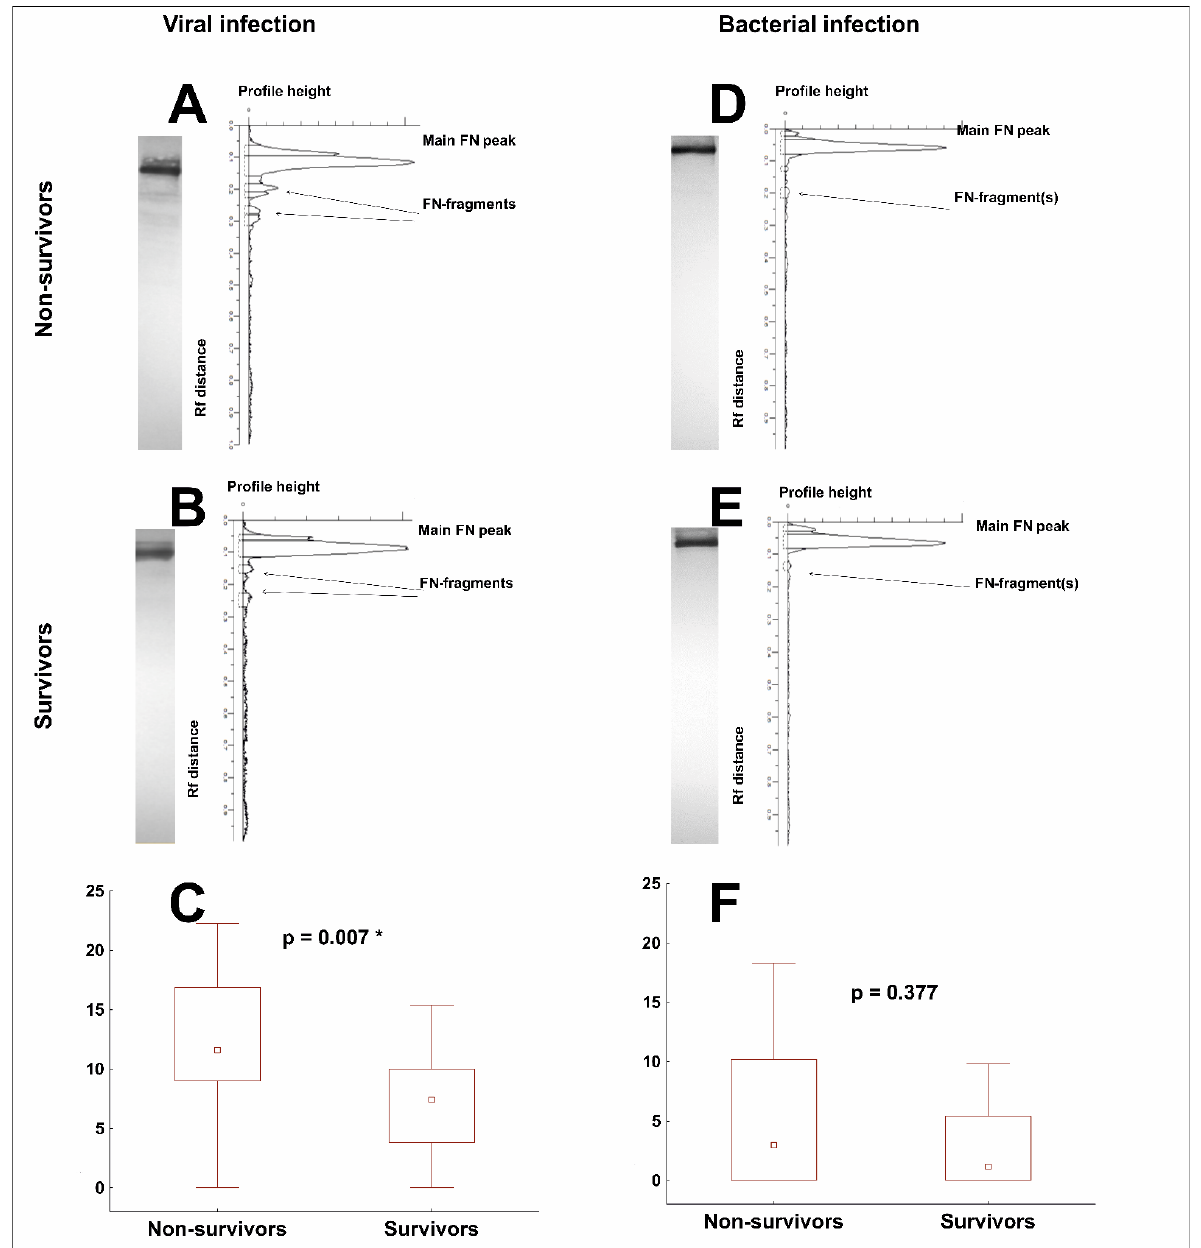
Figure 3. The occurrence of FN-fragments in the plasma of patients with a viral infection (COVID-19, left panel) or a bacterial infection (sepsis, right panel). Representative immuno-patterns of FN and FN-fragments and the corresponding densitograms for Non-survivors (graphs ( A , D )) and for Survivors (graphs ( B , E ). Correspondingly, graphs ( C , F ) compare the number of FN fragments, expressed as a percentage of all FN forms detected in the electrophoretic pathway between Non-survivors and Survivors. The box plots represent the median values (midpoint) with interquartile range between the 25th and 75th percentiles (box); the whiskers represent the minimum and maximum values. * indicates p -value less than